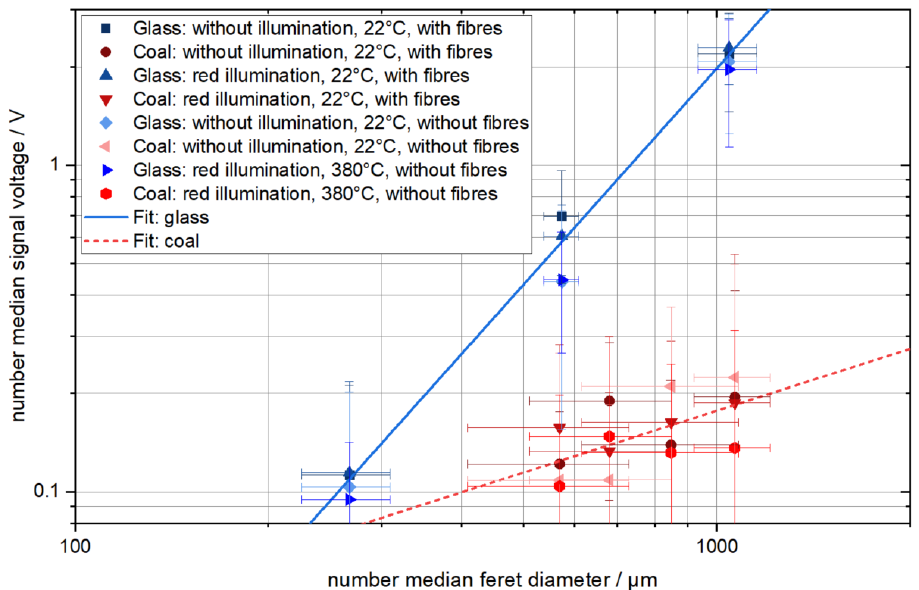
Figure 5. Number median signal voltage of the photomultiplier anode (signal voltage is the difference between peak voltage and average noise) gathered by measuring the light scattered on glass spheres or hard coal particles with different number median Feret diameter. Each point represents 20 measurements. The error bars represent the standard